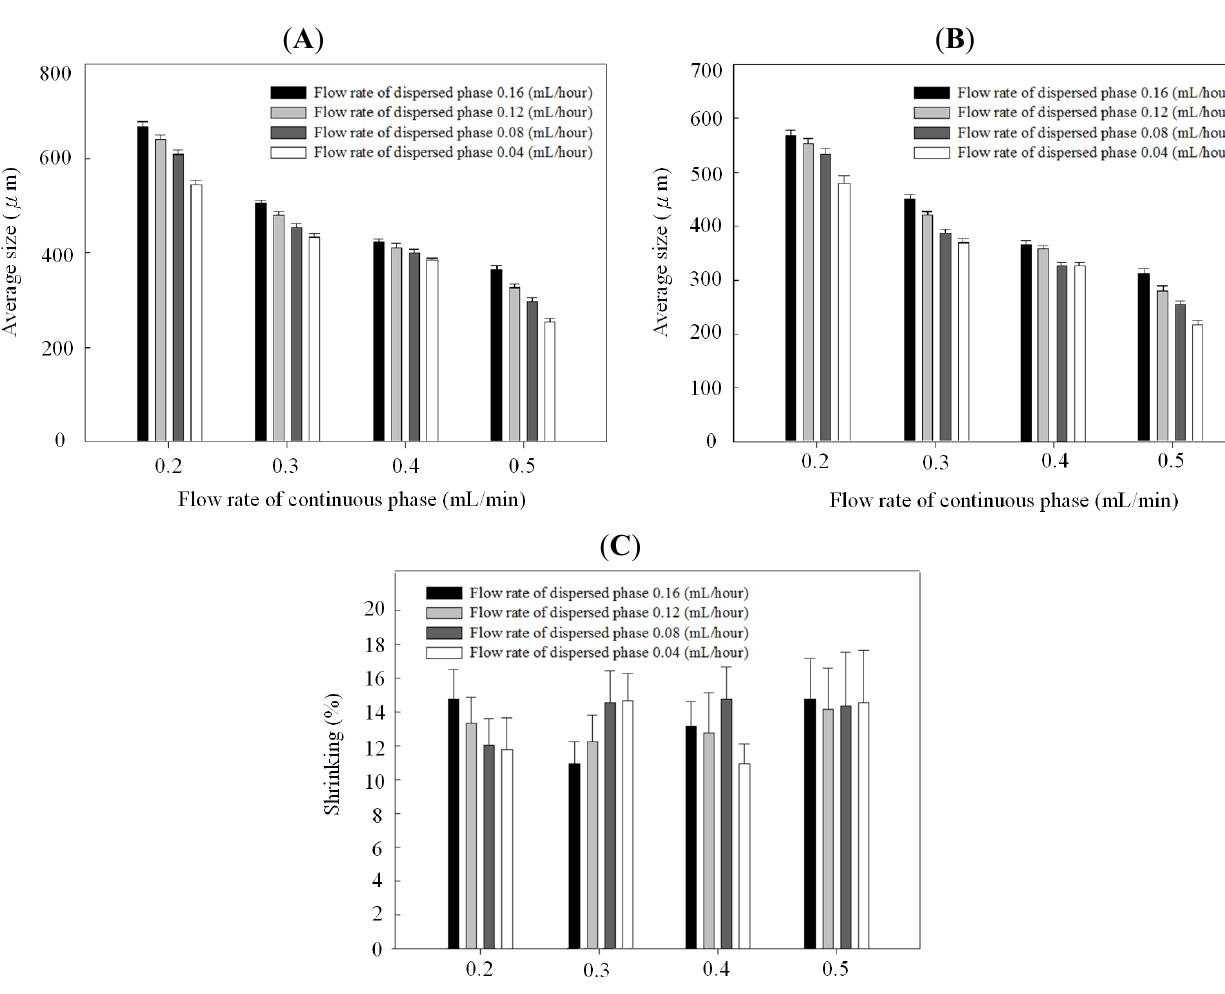
Figure 5. Droplet size ( A ), microparticle size ( B ), and shrinking ratio ( C ) of chitosan in different continuous/dispersed flow